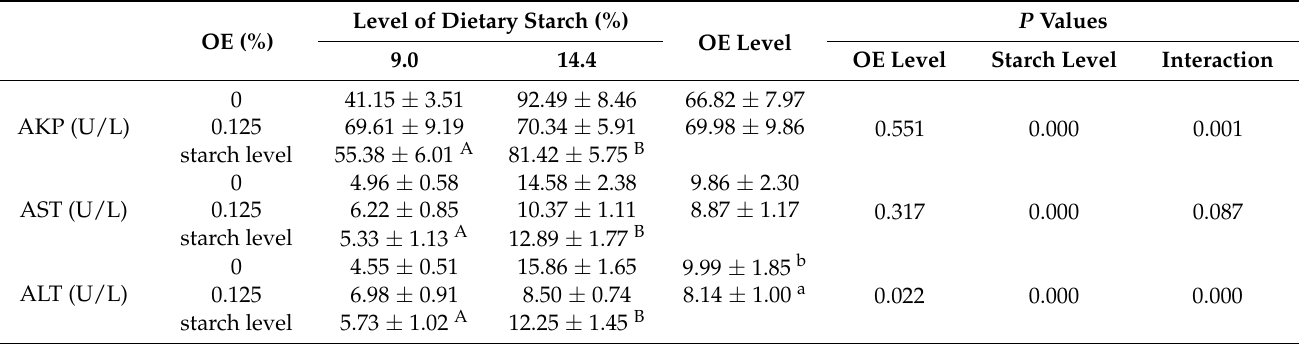
Table 7. Effects of experimental diets on hematological liver function in largemouth